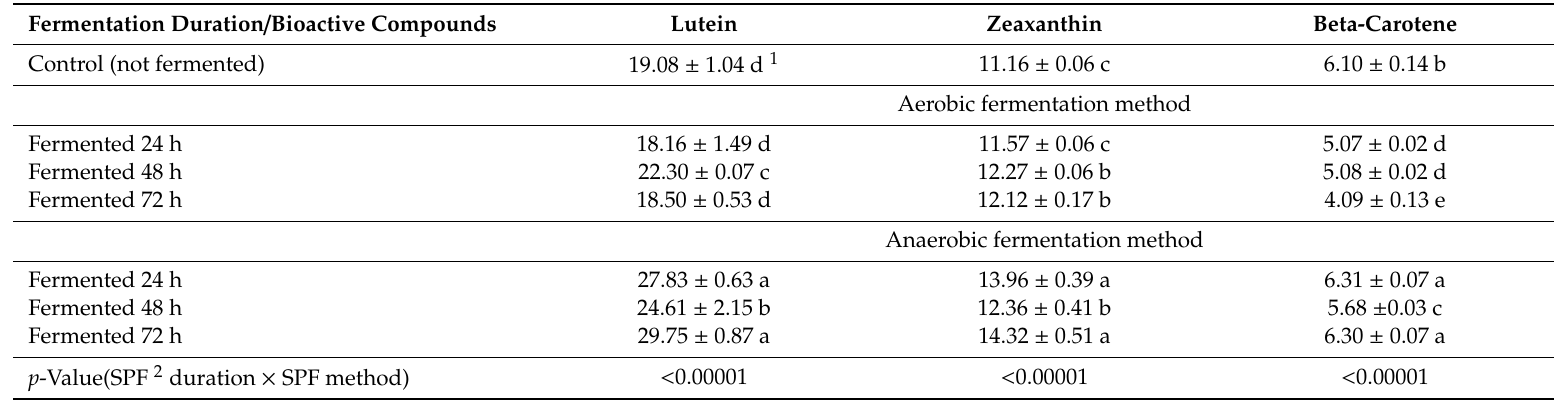
Table 5. The influence of SPF on the content of carotenoids (mg 100 g − 1 DW) in organic willowherb leaves. Mean value ± standard error, n =